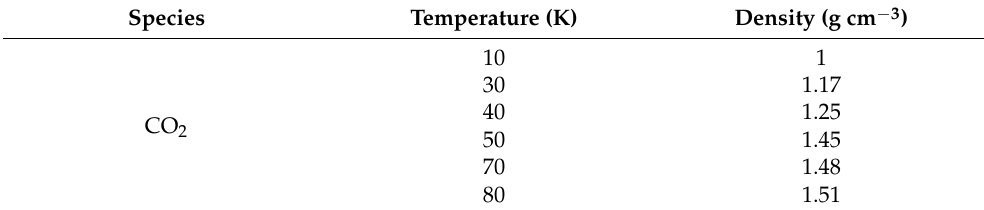
Table 2. Density of CO 2 ices at low temperatures as measured by Satorre et al. [41]. Species